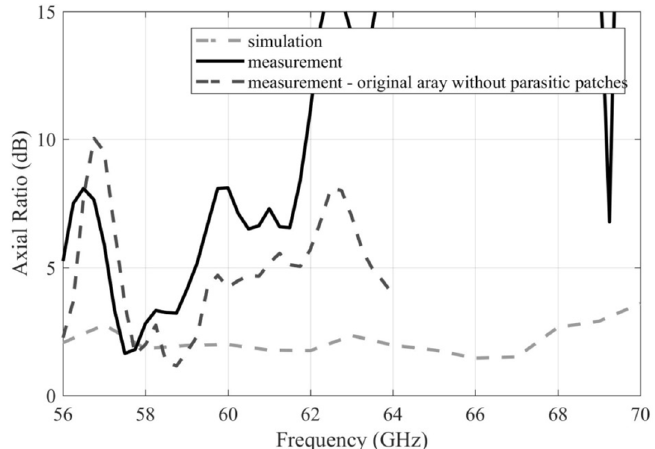
Figure 16. Frequency responses of the AR magnitude for the simulated and measured arrays extended with the parasitic patches.